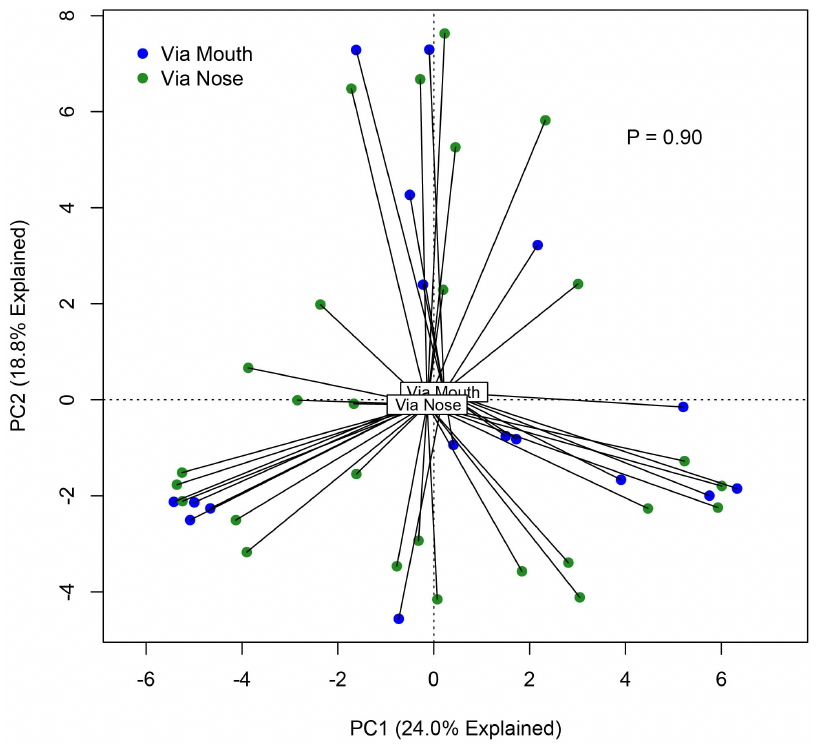
Figure 2. Comparison of transplant BAL specimens obtained via nasal and oral routes of bronchoscopy. Unsupervised principal component analysis (PCA) labeled by route of bronchoscope insertion. Group dissimilarity tested using ANOVA permutation test of ordination constrained by route of insertion.